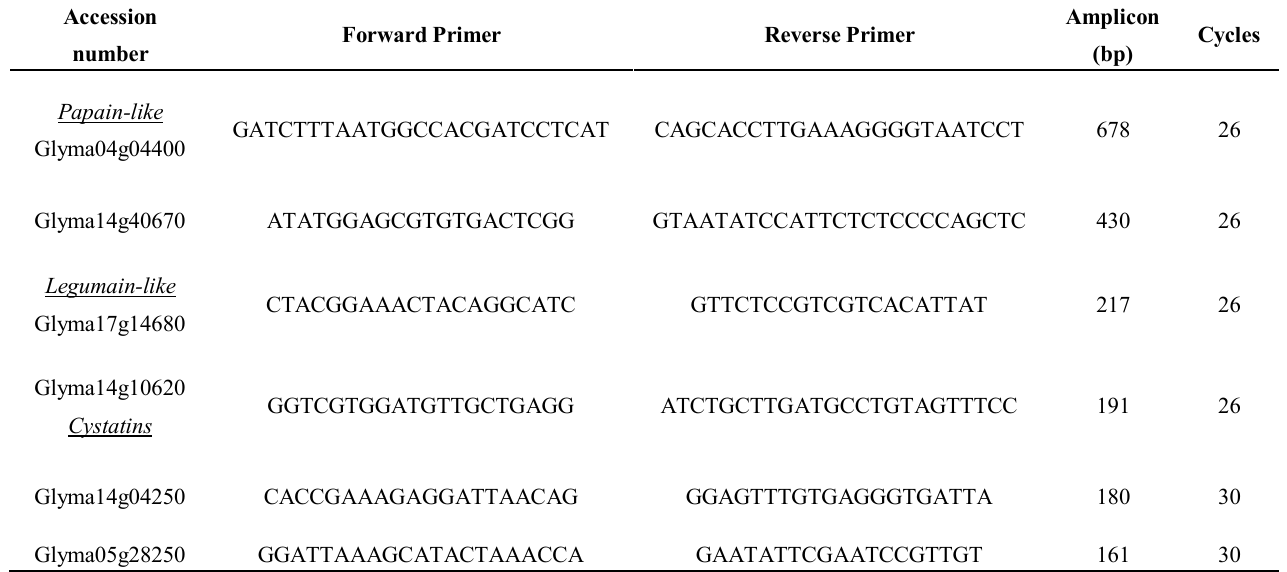
Table 1. Forward and reverse primers used for amplification of different papain- and legumain-like cysteine proteases and cystatins with size of amplicons produced and cycles required to obtain an amplification